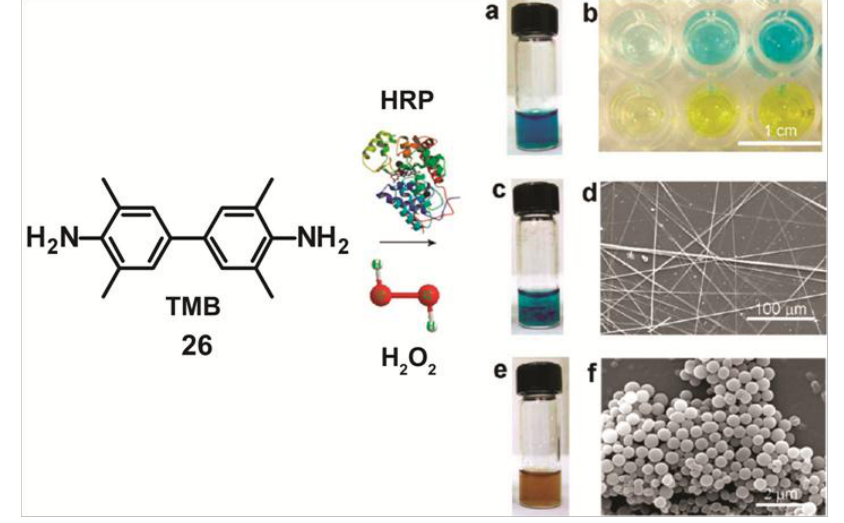
Figure 10. Color reaction and formation of nanostructures in the HRP/H O /TMB system. 2 2 ( a ) Oxidation of TMB by HRP/H O in acetate buffer (pH 4.0) produces a blue color; 2 2 ( b ) Blue color (top row) changes to yellow (bottom row) upon addition of sulfuric acid for typical ELISA analysis; ( c ) Blue nanobelts are formed after allowing the blue solution to react for 24 h at room temperature; ( d ) SEM image of nanobelts; ( e ) Upon mixing additional HRP to the blue mixture of aqueous solution and nanobelts, the color of the system turned brown, accompanied by precipitation of uniform nanoparticles; ( f ) SEM image of nanoparticles. Reprinted or adapted with permission from [47]. Copyright 2011 American Chemical